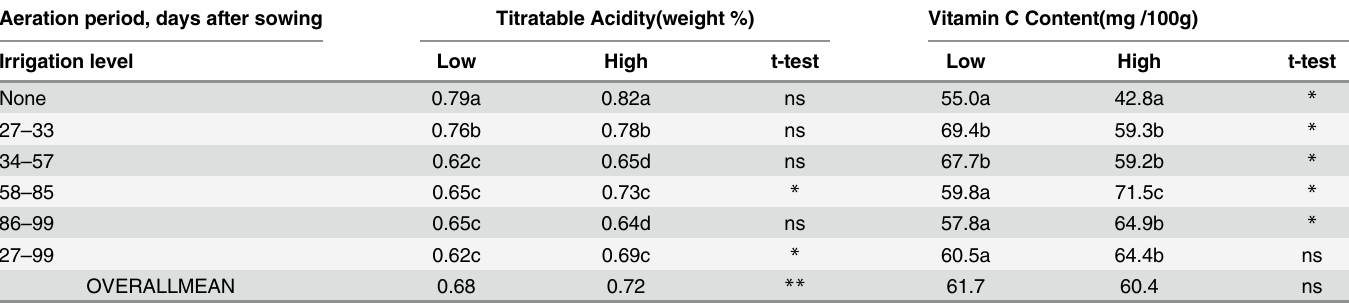
Table 4. Irrigation × post-infiltration aeration interaction on titratable acidity and vitamin C content (fresh weight basis) of the first ripe fruit from the first truss of potted single tomato plants (n = 3). Aeration treatments were none or 2.5 liter aeration applied during 5 different periods. Pots were sub- surface drip-irrigated at 2-day intervals to maintain the soil at 60 to 70% or 70 to 80% of volumetric field capacity (denoted as low and high irrigation level). Aeration period, days after